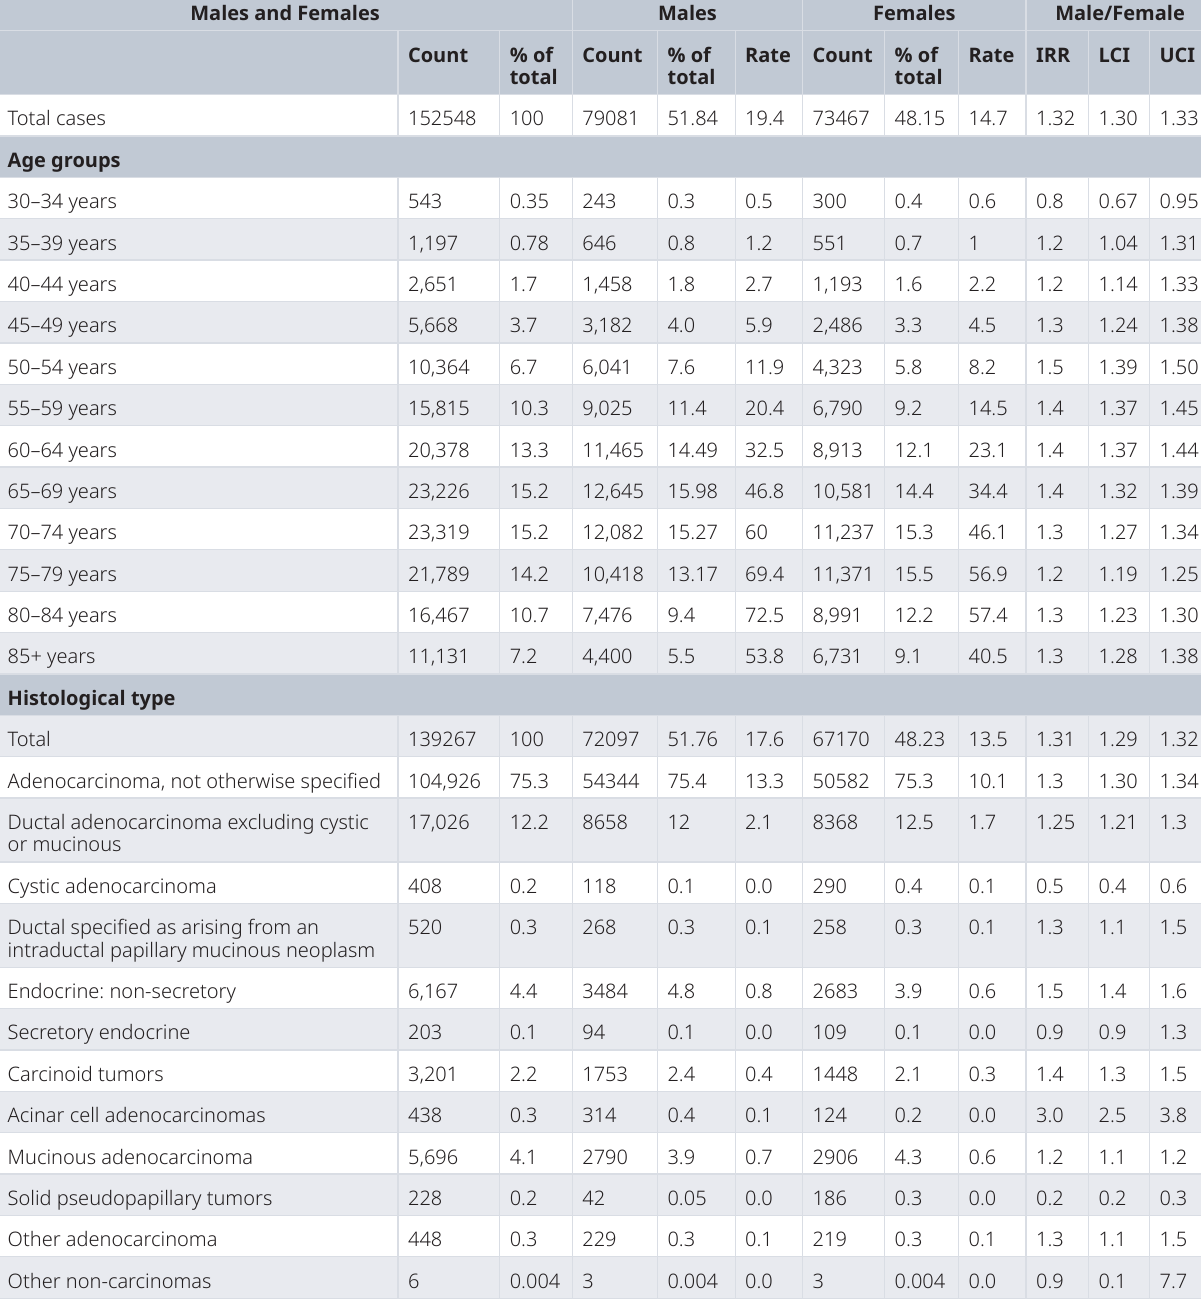
Table 3. Total cases, rates, and male to female incidence rate ratios, by age group and histologic type (2000–2017). Males and Females Males Females Male/Female Count % of total